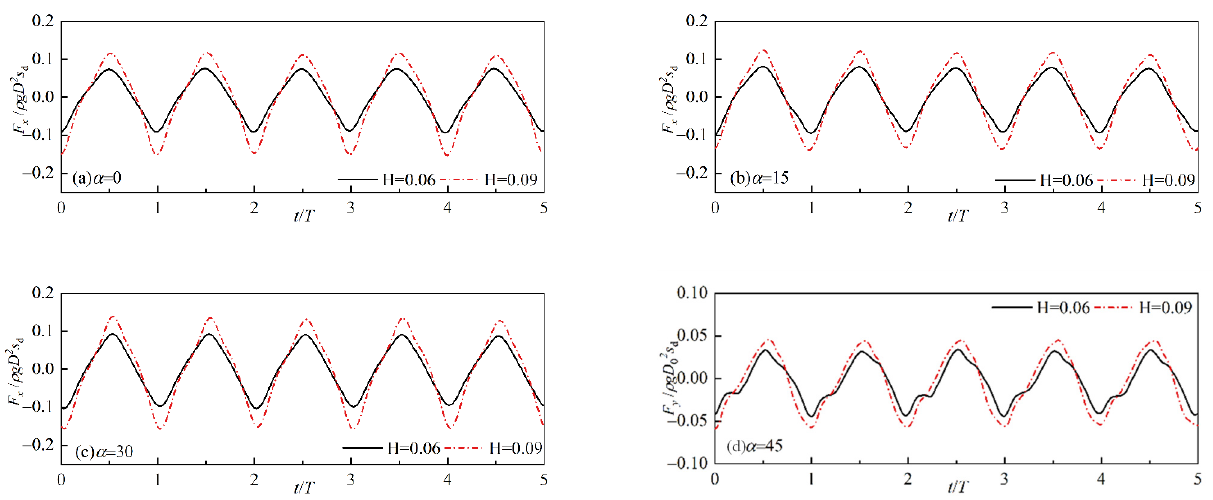
Figure 9. Time histories of longitudinal wave forces for wave cases of T = 0.9 s, H = 0.06m and 0.09m with incident direction of ( a ) α = 0°, ( b ) α = 15°, ( c ) α = 30°, ( d ) α =